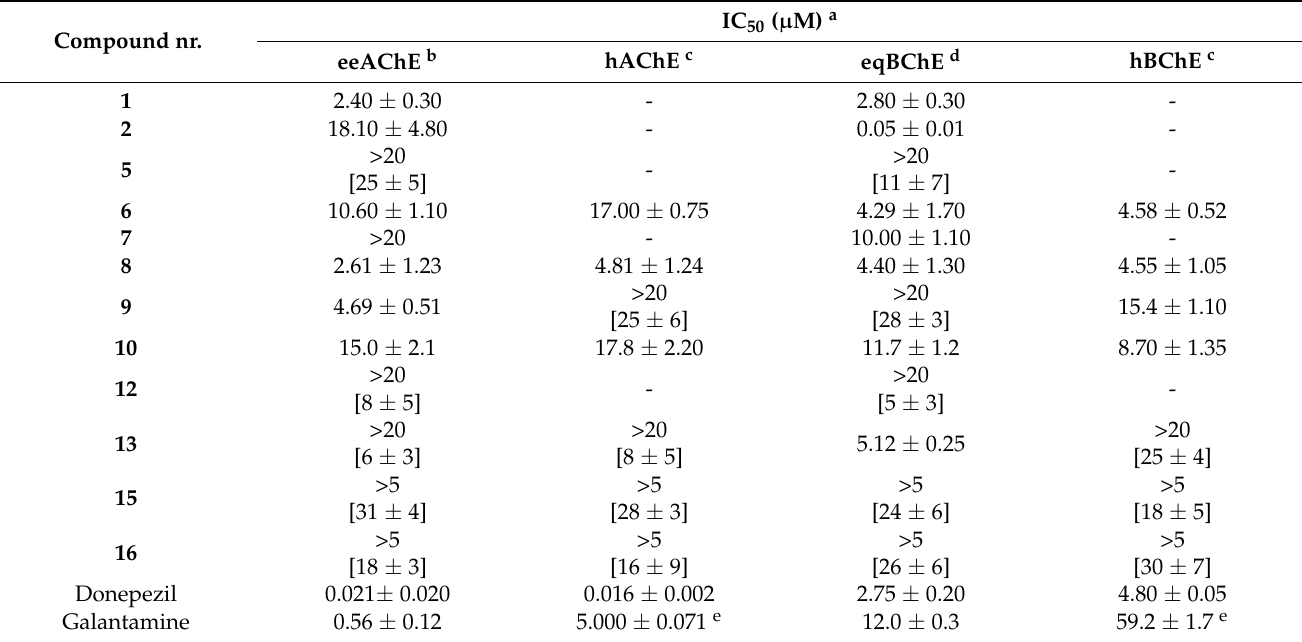
a IC 50 values determined by interpolation of the sigmoidal dose-response curves as obtained by regression with GraphPad Prism software (version 5.01) of at least seven different data points, or inhibition percentage at the higher tested concentration (20 µ M) in parentheses; data are means ± SD of three independent measurements. Donepezil and Galantamine were used as positive controls. Reported data have been experimentally obtained, and values found accordingly with the literature. b Electric eel acetylcholinesterase. c Recombinant human isoform. d Horse serum butyrylcholinesterase. e Values obtained from the literature determined for brain AChE and serum BChE